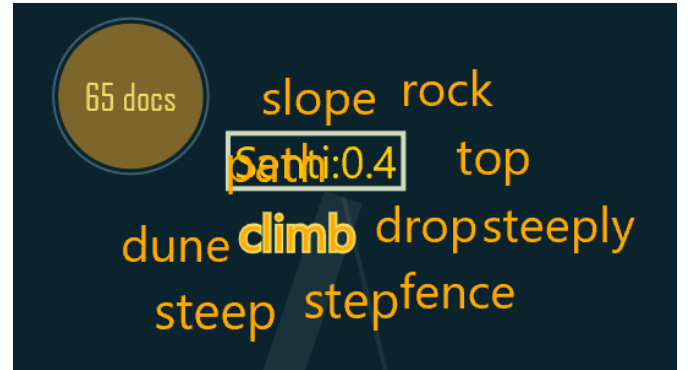
Figure 7. Word cloud of “climb” generated by A1.